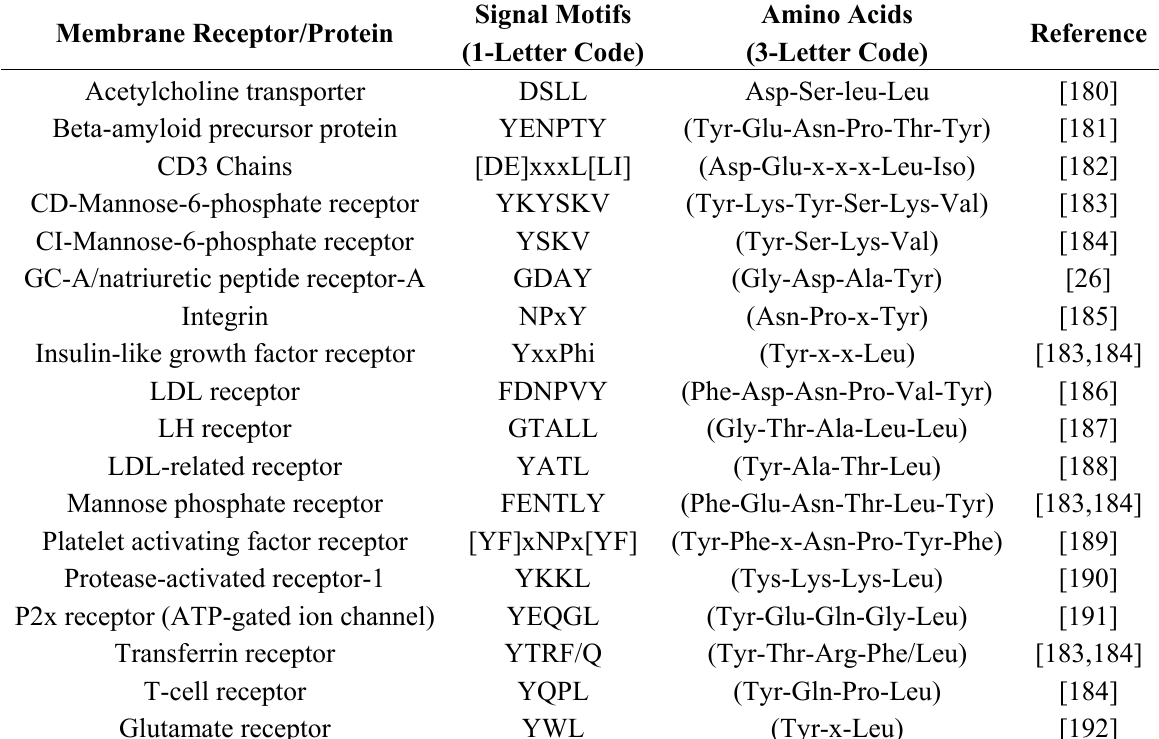
Table 1. Selected short-sequence motifs for internalization and trafficking of membrane receptors and